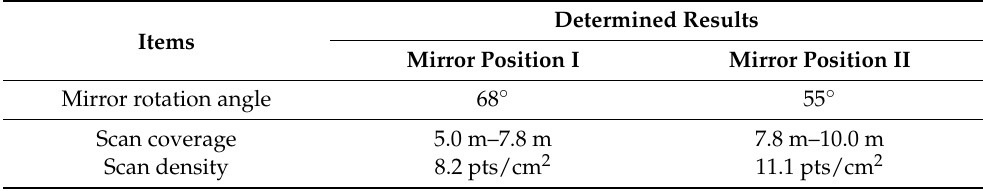
Figure 12. Determination of the mirror position, mirror size and mirror rotation angles for mirror-aided approach. Table 6. Determination of the mirror rotation angle for the scan area to be